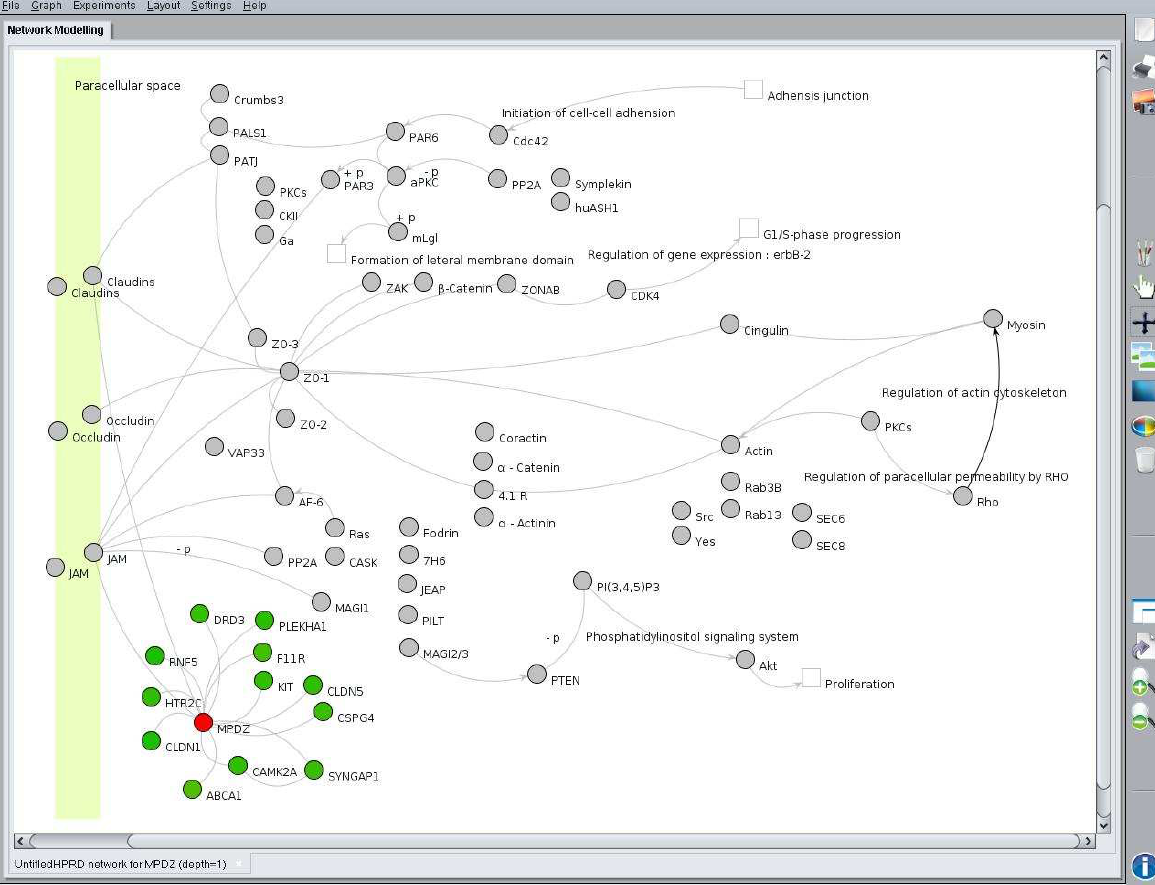
Figure 4: Visualization of the Tight junction signaling pathway (hsa04530) by VANESA. The place marked in red is the relevant protein of the microarray